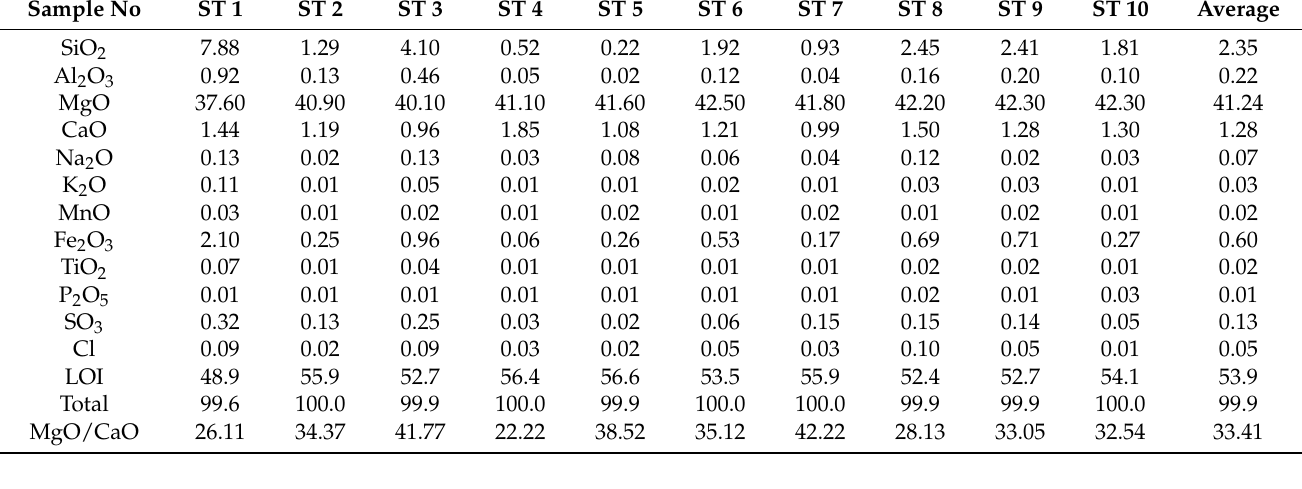
Figure 3. Representative X-ray diffraction pattern of the stromatolite samples in Lake Salda for ST- 1, ST-6 and ST-9 samples.